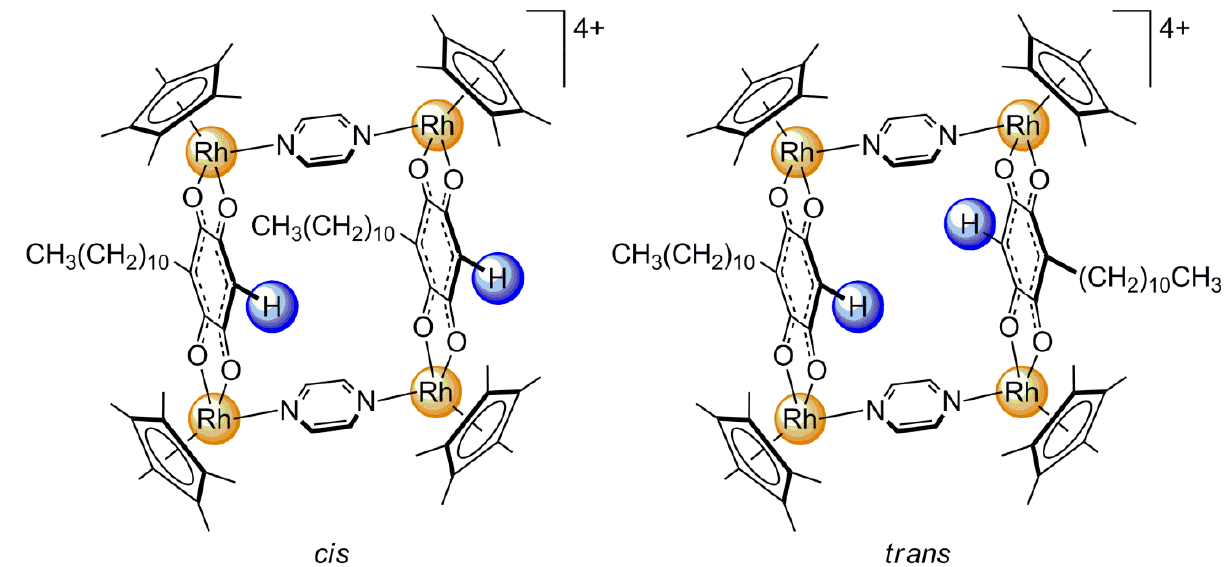
Electrospray ionization (ESI) mass spectra of complexes [ 3 ](CF